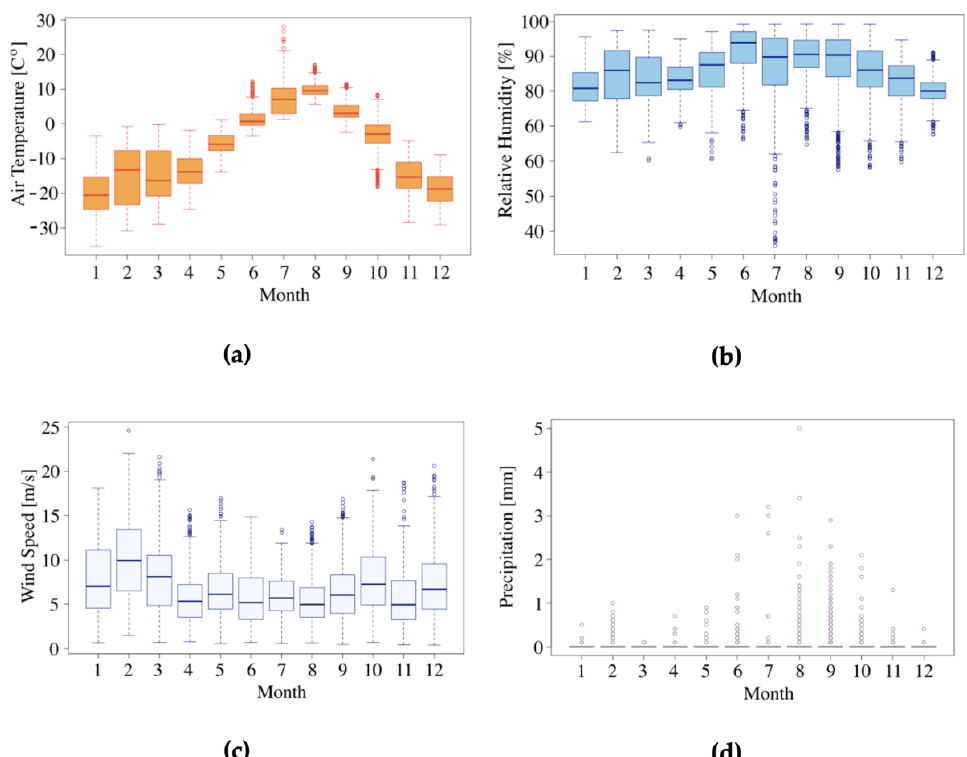
Figure 3. Variability of the monthly mean air temperature ( a ), relative humidity ( b ), wind speed ( c ), and daily precipitation amounts ( d ) for the period of observations at the measurement station “DIAMIS”. On each box, the central line shows the median. The bares represent the lower “hinge” and the upper “hinge” and the extremes of the upper and lower whiskers. Dots indicate outliers. The analysis of multi-year wind distribution for the study area based on the longer-term data records from the weather station “The Island of Dikson” (WMO ID: 20674), located at proximity to the measurement site (3.7 km to the northwest), shows a predominance of northeast and southwest wind directions throughout the seasons (Figure 4).